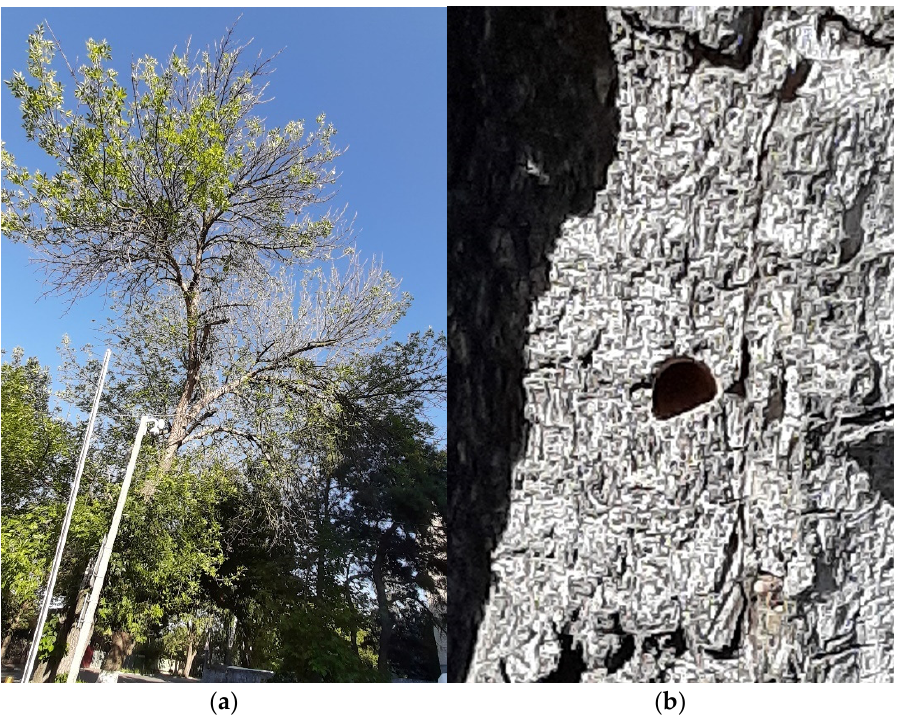
Figure 1. The declined tree of Fraxinus pennsylvanica ( a ) with characteristic D-shaped exit holes of Agrilus planipennis ( b ) found at Dzerzhinskogo Street in Azov (47.115237 N, 39.422158 E).